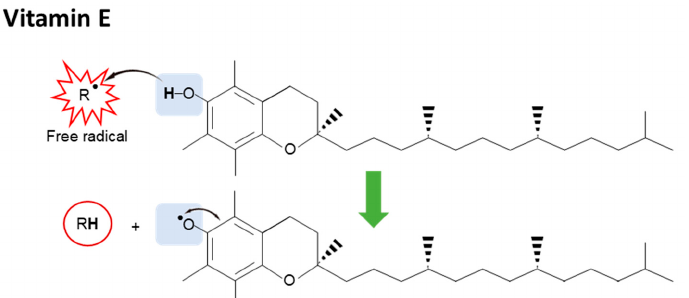
Figure 1. Antioxidants (vitamin E) in rice and structure-activity relationship. Vitamin E exerts its antioxidant effects by quenching free radicals. The hydroxyl group on chromanol ring can donate its hydrogen atom to a free radical resulting in a delocalized and stabilized unpaired electron, vitamin E radical.